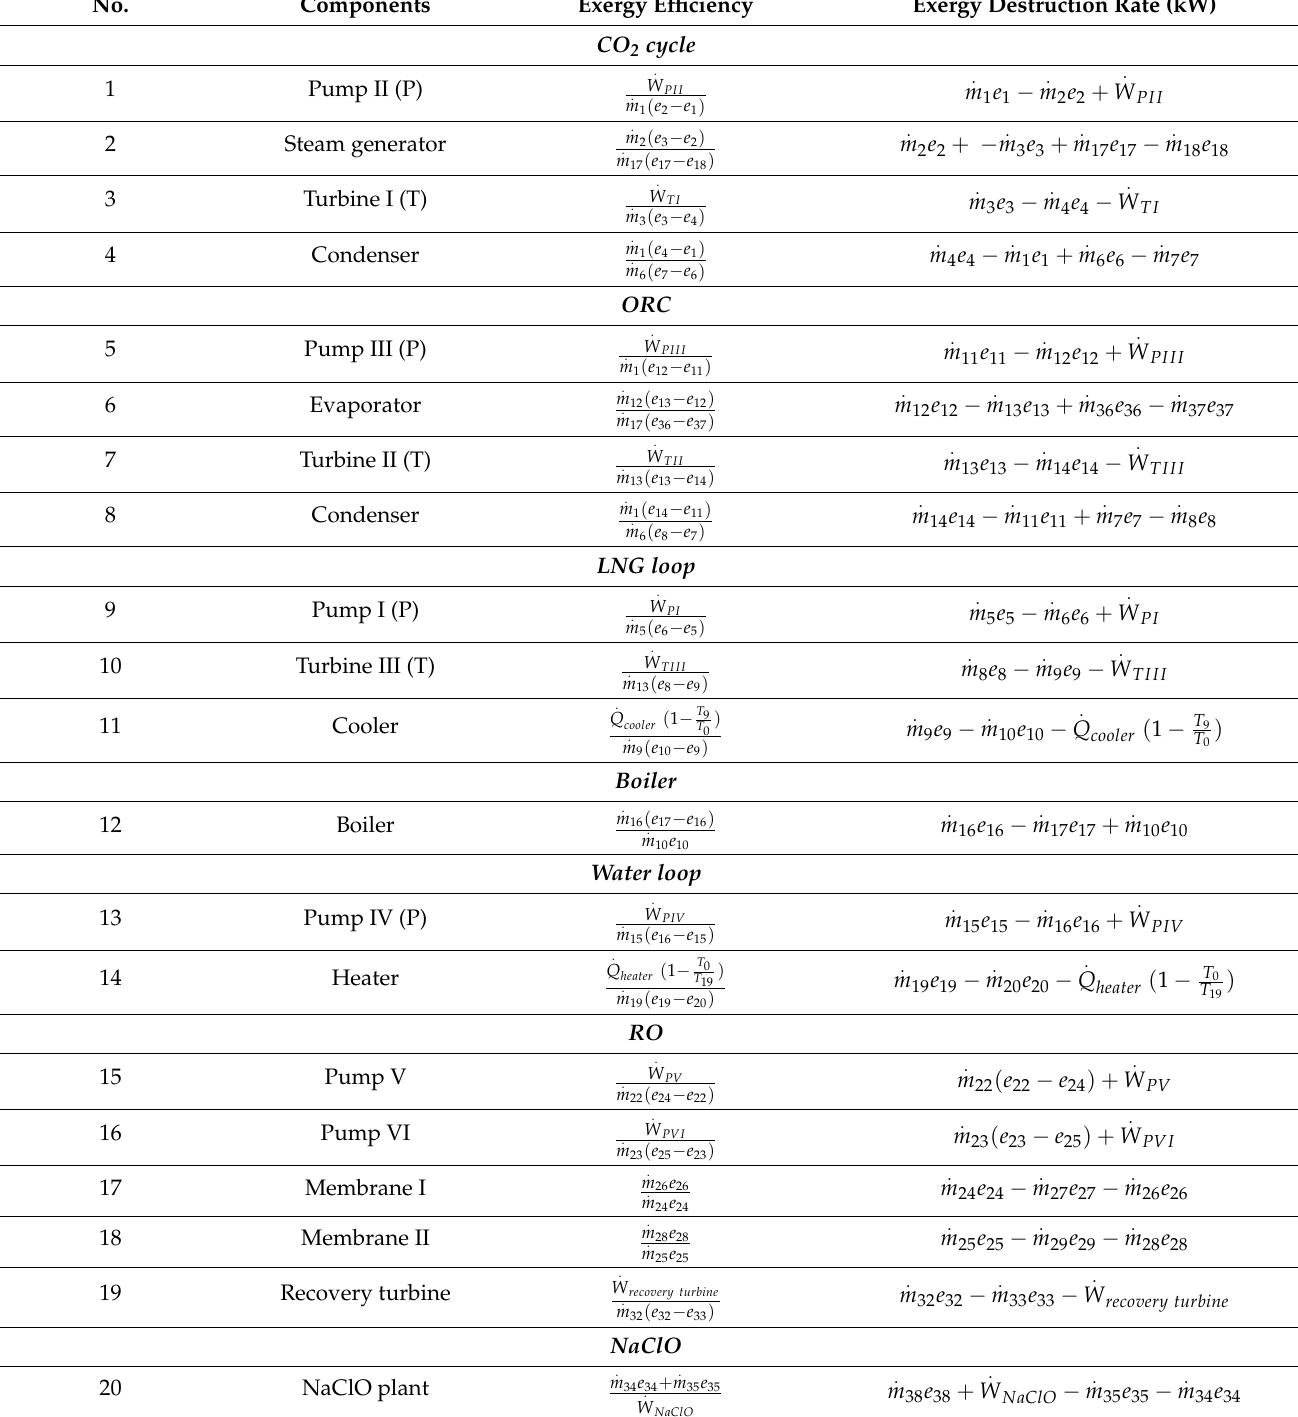
Table 5. The exergy destruction rates and exergy efficiencies for system